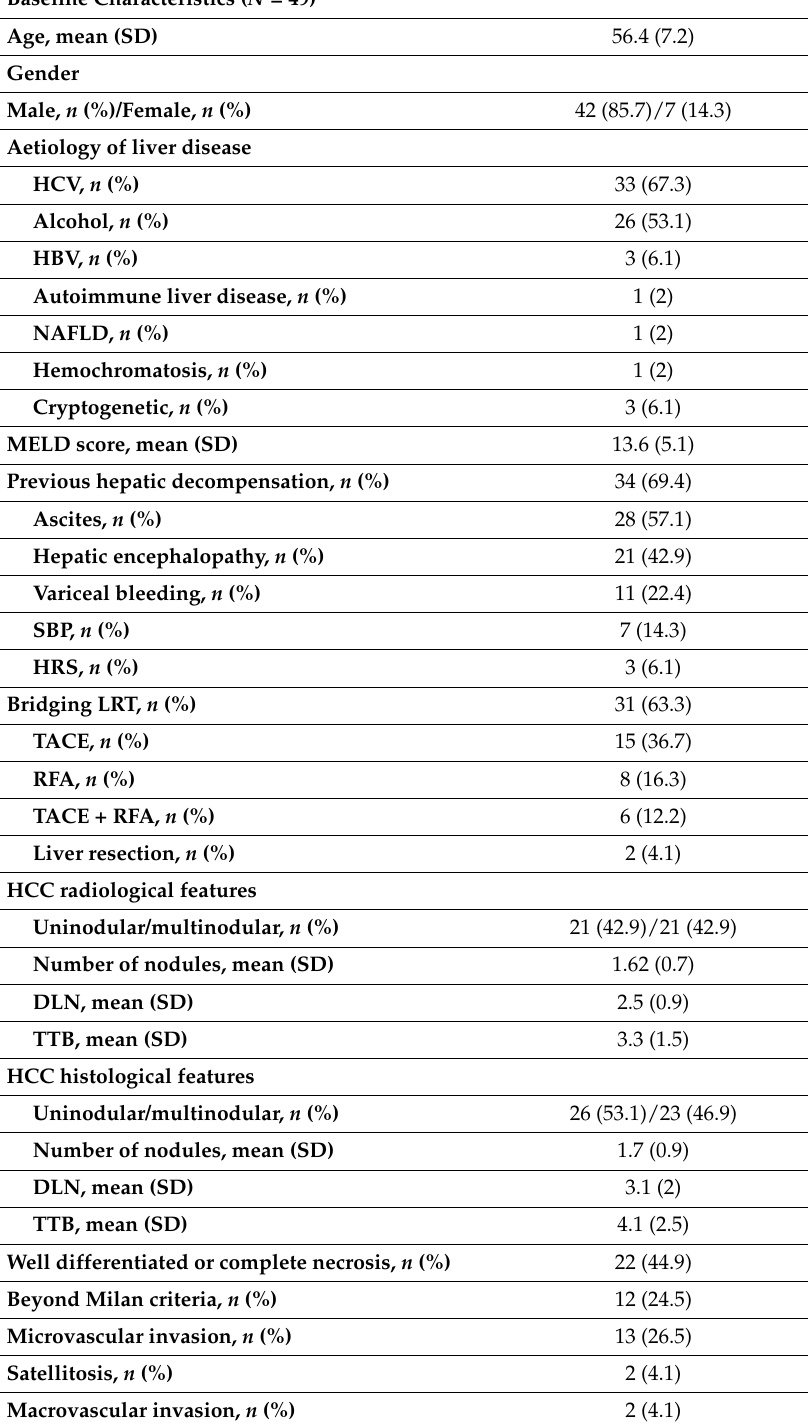
Table 1. Demographic, clinical characteristics and histological features of 49 patients with hepatocellular carcinoma who underwent liver